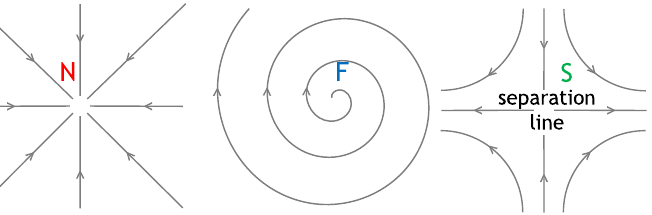
Figure 1. Types of skin friction pattern around a critical point: node (N), for example, here attracting; focus (F), for example, here repelling; and saddle point (S) with the separation